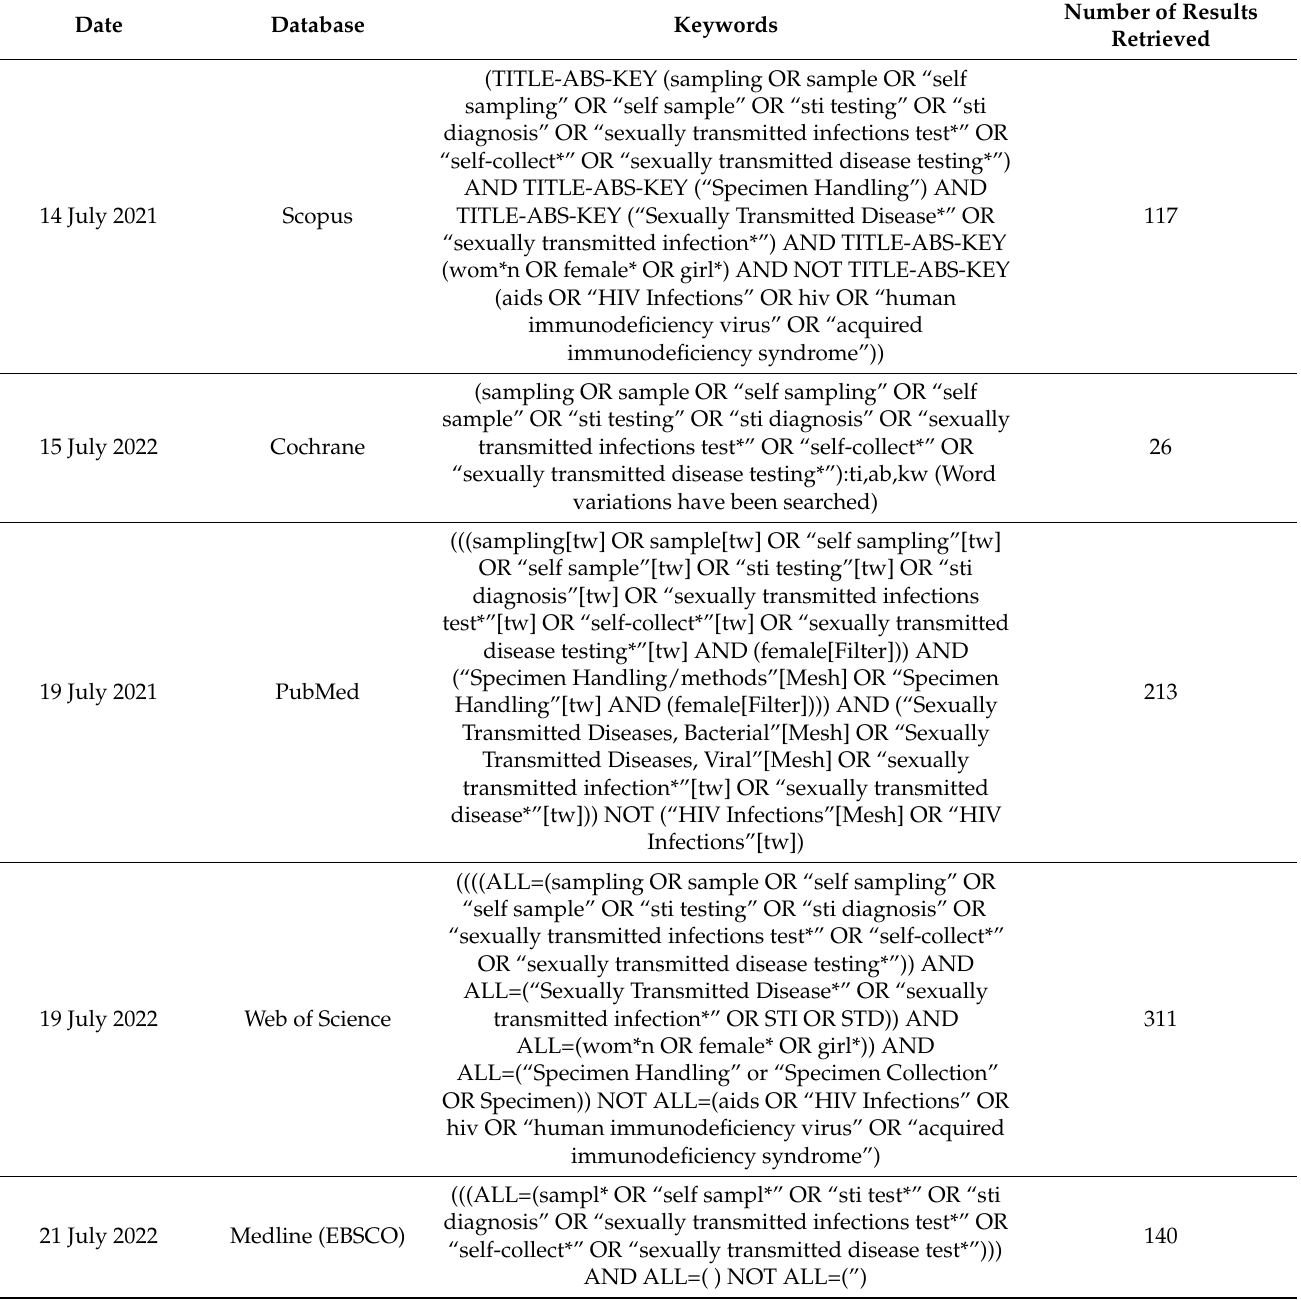
Table 2. Results of the database